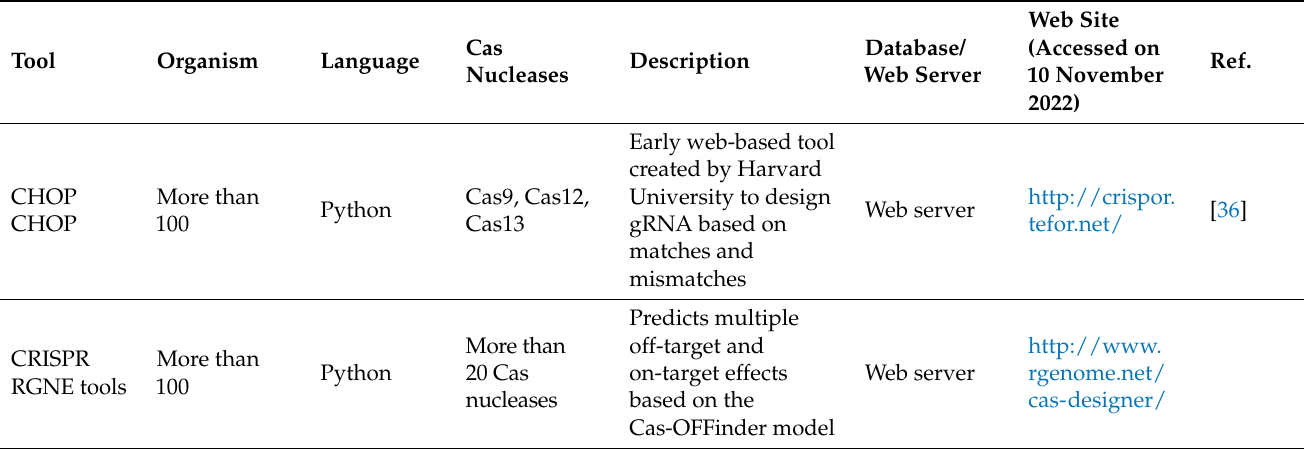
Table 2. Commonly used gRNA design